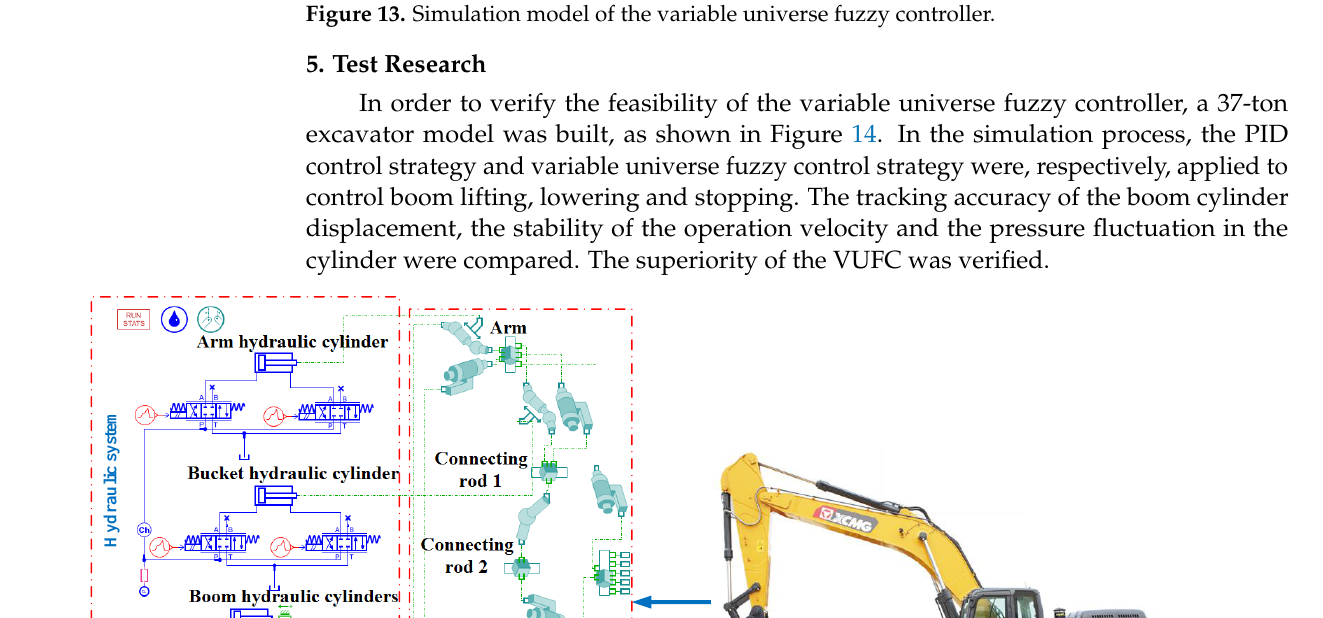
Figure 13. Simulation model of the variable universe fuzzy controller.